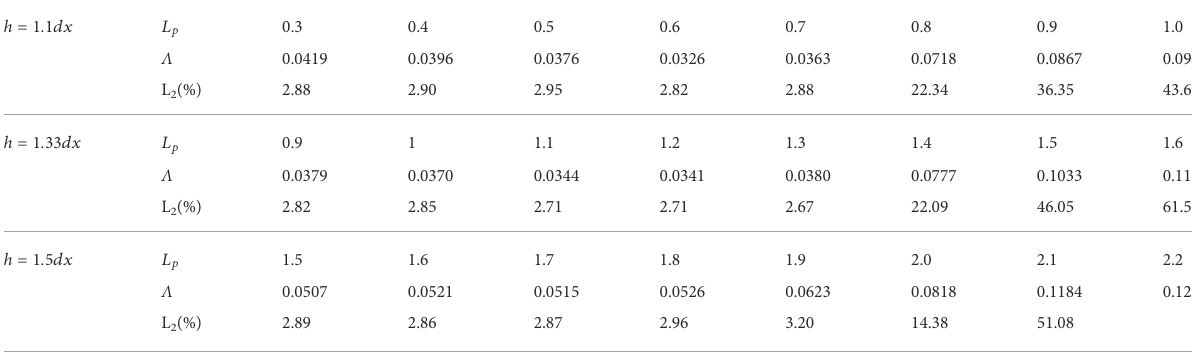
TABLE 1 In fl uence of L p on particle inconsistency and numerical error in Lind ’ s PST.